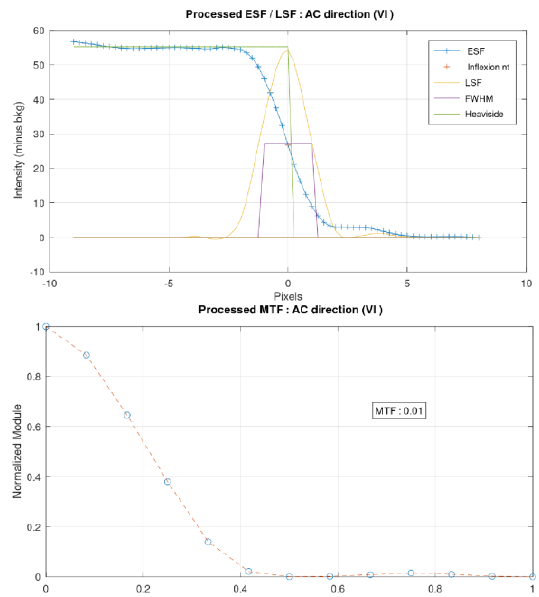
Figure 8. The ESF, LSF, FWHM, SNR, RER and MTF results from the green band HD obtained from the airport in